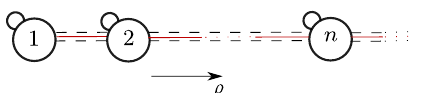
JHEP02(2023)193